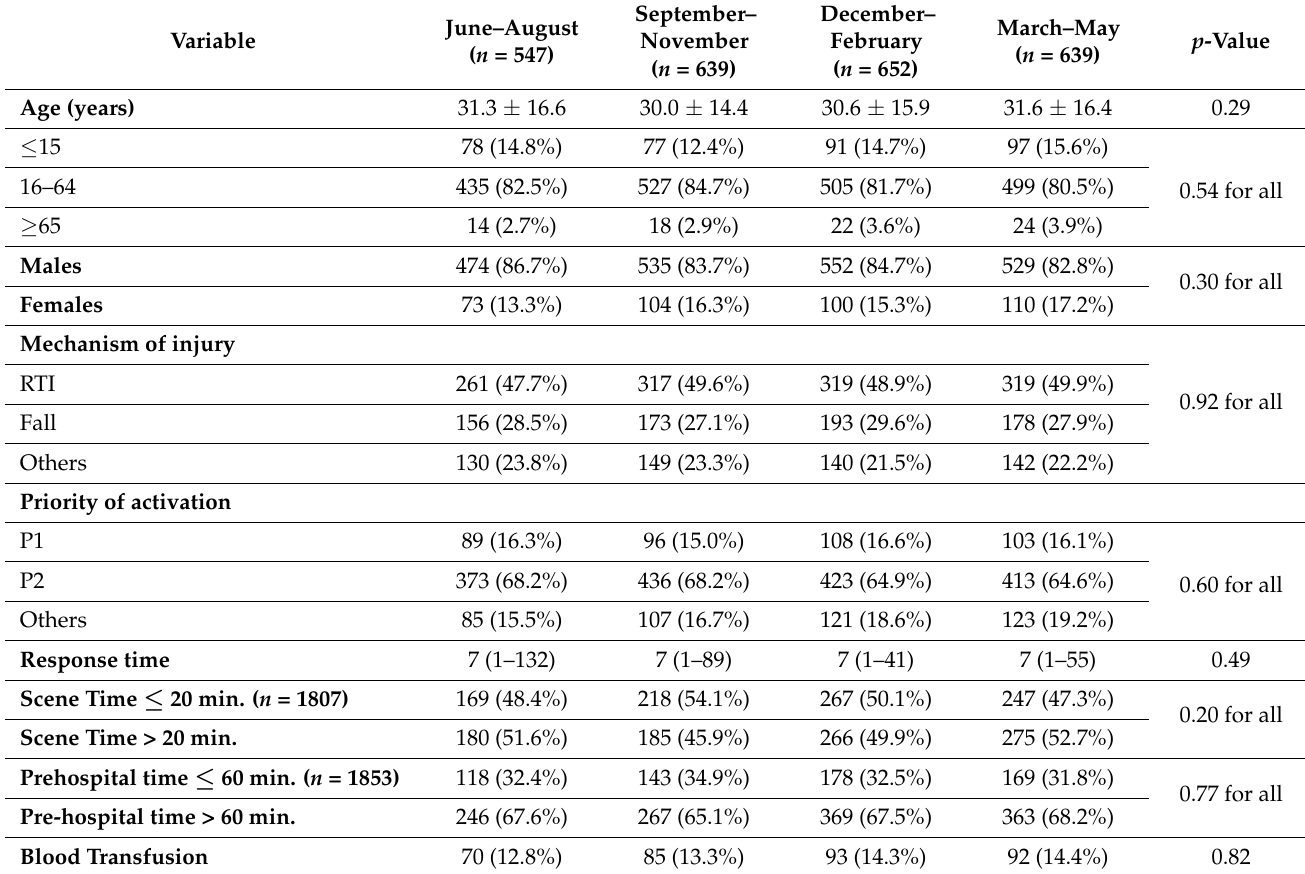
Table 3. Comparison of demographics and outcomes by